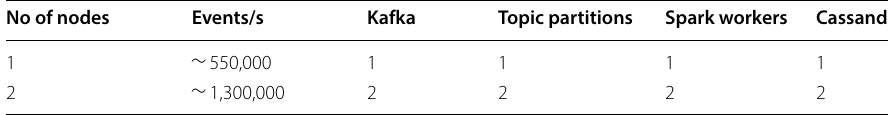
Table 4 Conducted